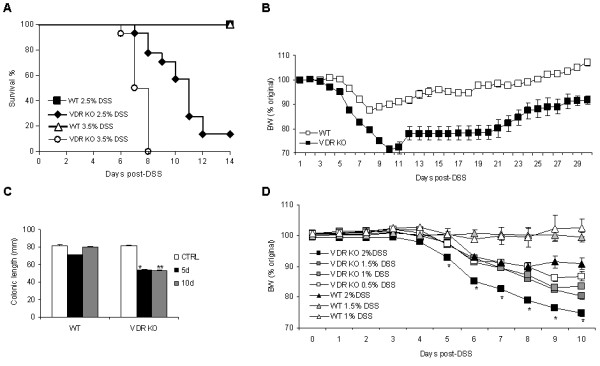
Increased mortality of VDR KO mice following DSS administration. A) Survival curves in VDR KO and WT mice induced to develop DSS colitis. VDR KO mice died following 2.5% or 3.5% DSS treatment while all of the WT mice survived regardless of DSS concentrations. B) BW recovery over time post-DSS treatment. Mice were treated with 2.5% DSS for 5 days. VDR KO mice failed to recover BW following cessation of DSS. C) Colon length at day 0 (control-CTRL), day 5 and day 10 of DSS-exposure in WT and VDR KO mice. D) VDR KO mice were administered 0.5%–2% and WT mice received 1–2% DSS (n = 5/group). BW changes were monitored, and the values are expressed as the percentage of original BW. *Values from VDR KO mice were significantly different than corresponding values from WT mice. ** WT day 10 colon lengths were significantly longer than WT day 5 colon lengths.